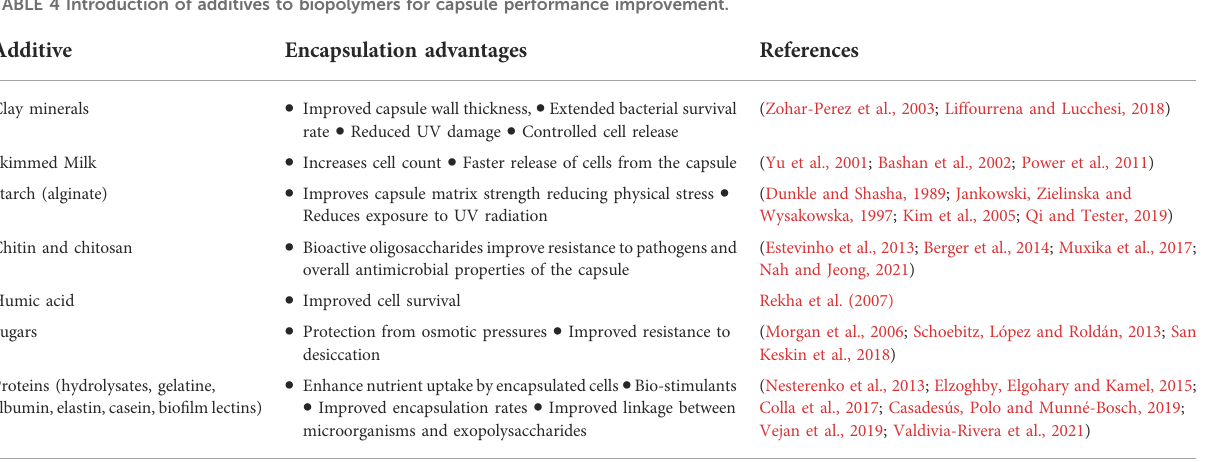
TABLE 4 Introduction of additives to biopolymers for capsule performance